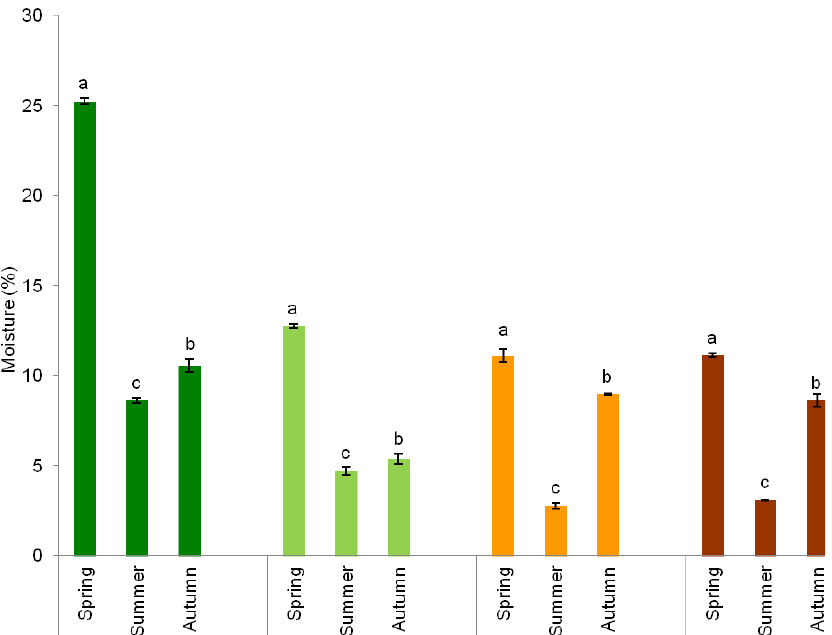
Figure 1. Luvisol moisture in midfield shelterbelt (S), the border between the shelterbelt and the triticale field (B), cultivated field at a distance of 50 m from point B (F 50 ), and cultivated field at a distance of 100 m from point B (F 100 ) determined on three different dates (average values ± standard deviation; n = 3). Different letters indicate significant differences; ANOVA carried out separately for measuring point and sampling time, p < 0.05.